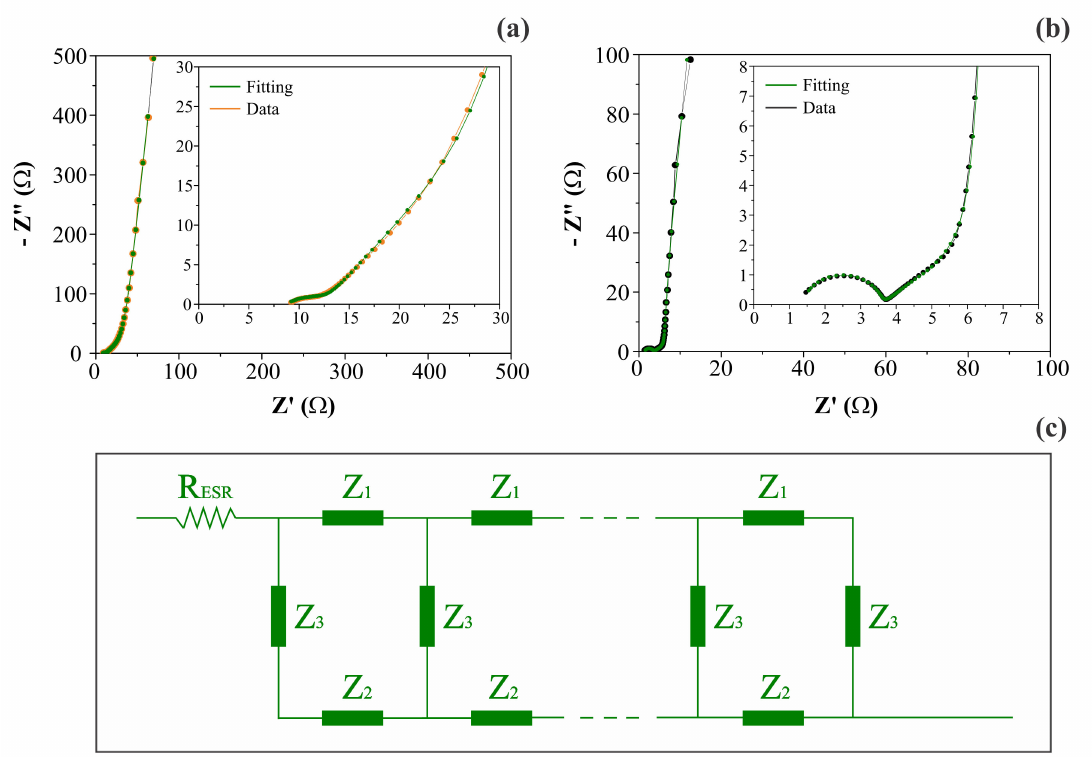
Figure 6. Complex plane plots ( a , b ) and the generic double-channel transmission line model ( c ), including the anomalous transport for porous/disordered electrodes. Plots ( a ) and ( b ) refer to CNF and NiO@CNF electrodes, respectively. Impedances Z 1 and Z 2 are composed of a circuit containing an ohmic resistor ( R ) parallel to a constant phase element (CPE). A CPE represents the interface ( Z 3 )